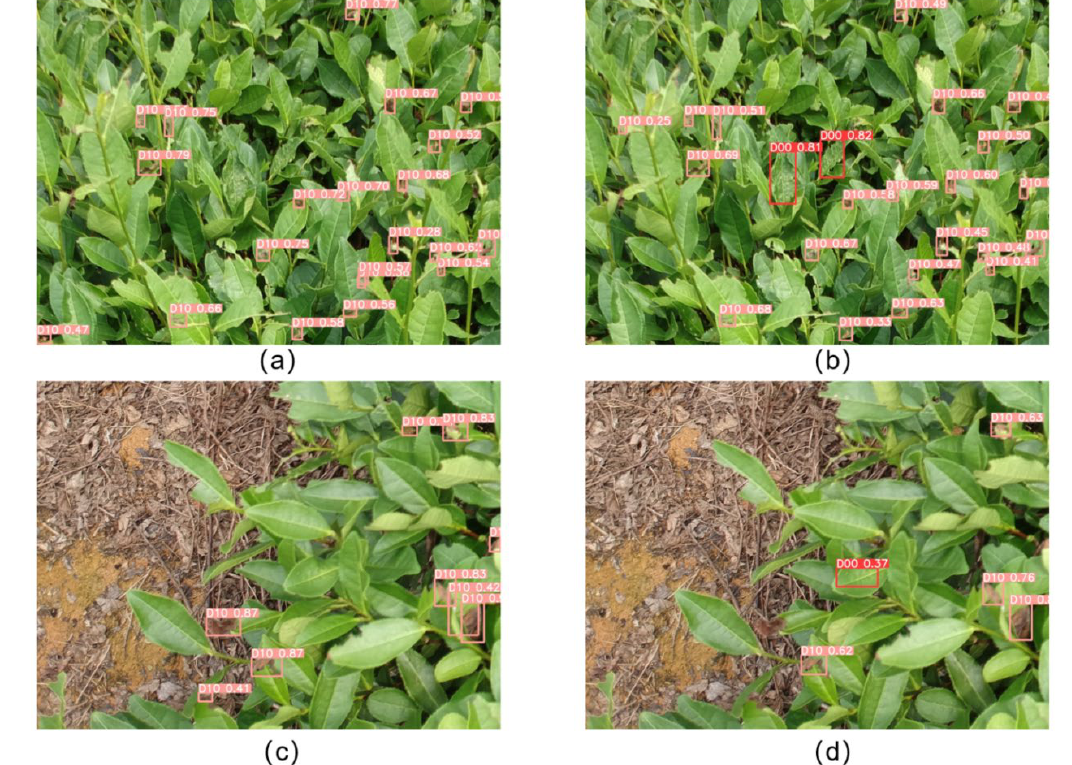
Figure 9. Comparison of model detection results. ( a ) YOLOv5's detection results. ( b ) YOLOv5-Tea’s detection results. ( c ) YOLOv5's detection results. ( d ) YOLOv5-Tea’s detection results. In Figure 9a, YOLOv5s detected 21 targets of tea leaf blight disease. However, these 21 tea leaf blight targets contained one false detection and one duplicate detection. There were also two missed targets for green mirid bug infestation. A total of 20 targets for the tea leaf blight disease and two targets for the green mirid bug pest were correctly identi- fied by YOLO-Tea in Figure 9b. In Figure 9c, YOLOv5s detected seven tea leaf blight dis- ease targets correctly, but missed one green mirid bug target and detected two tea leaf blight disease targets incorrectly. In Figure 9d, YOLO-Tea correctly detected four tea leaf blight disease targets and one green mirid bug pest target, though. However, three tea leaf blight disease targets were missed.